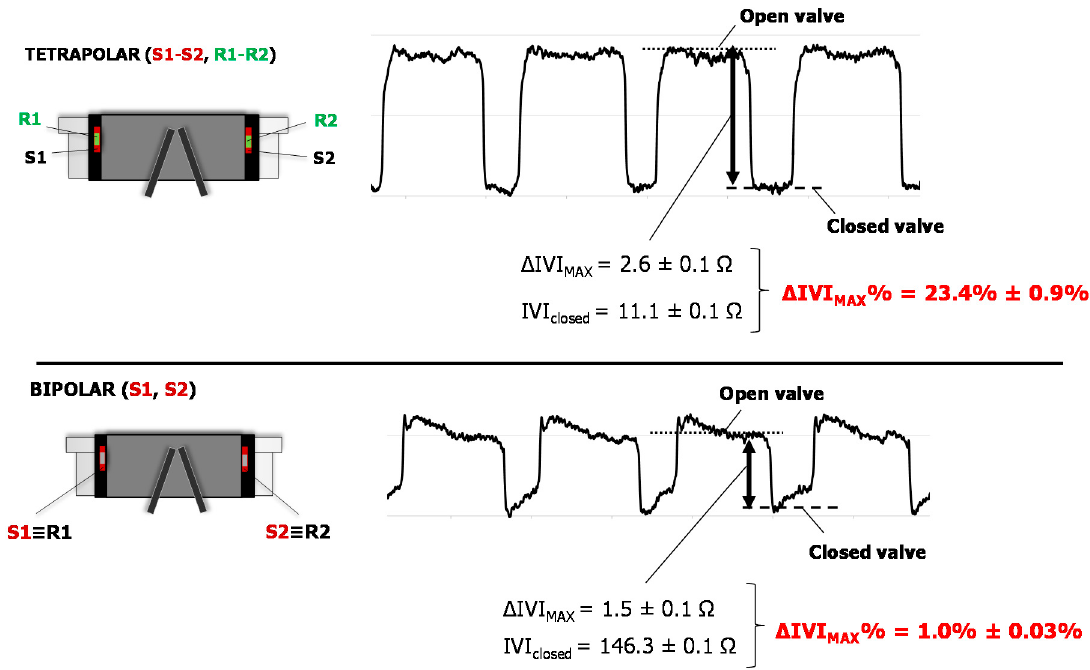
Figure 5. IVIsignalrecordedfortetrapolar( top )andbipolar( bottom Figure 5. IVI signal recorded for tetrapolar ( top ) and bipolar ( bottom ) impedance measurement configurations.